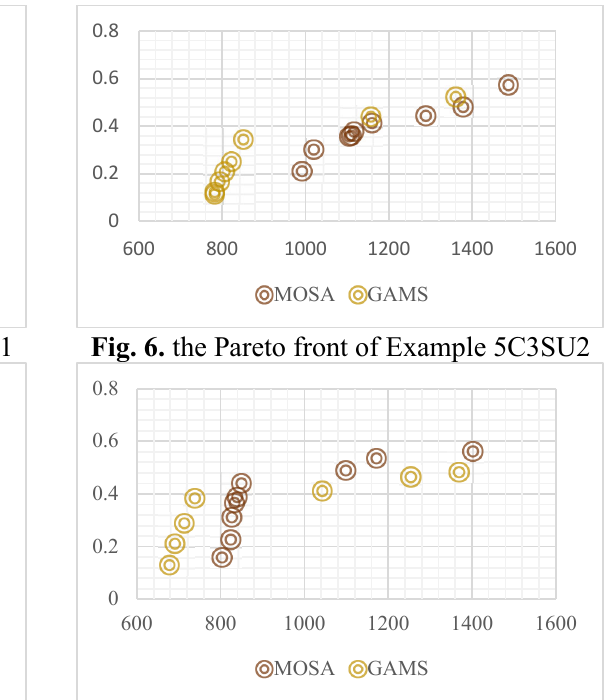
Fig. 7. the Pareto front of Example 5C3SU4 Fig. 8. the Pareto front of Example 5C3SU4